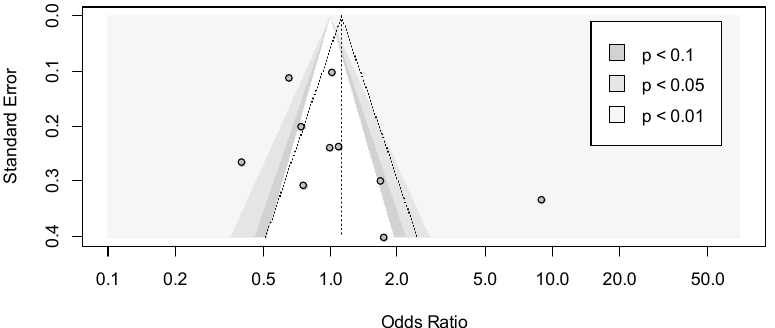
Figure 5. The contour funnel plot of the meta-analyses of car accidents and non-car accidents with OSAS, with contours of statistical significance at 1%, 5% and 10%. It is helpful to investigate if in a meta-analysis, some studies could have been suppressed based on their statistical significance. This representation facilitates the assessment of whether the areas where studies exist are areas of statistical significance and whether the areas where studies are potentially missing correspond to areas of low statistical significance. The funnel plot does not seem to be asymmetrical, and there seems to be a balanced distribution of studies based on the significances of their results.